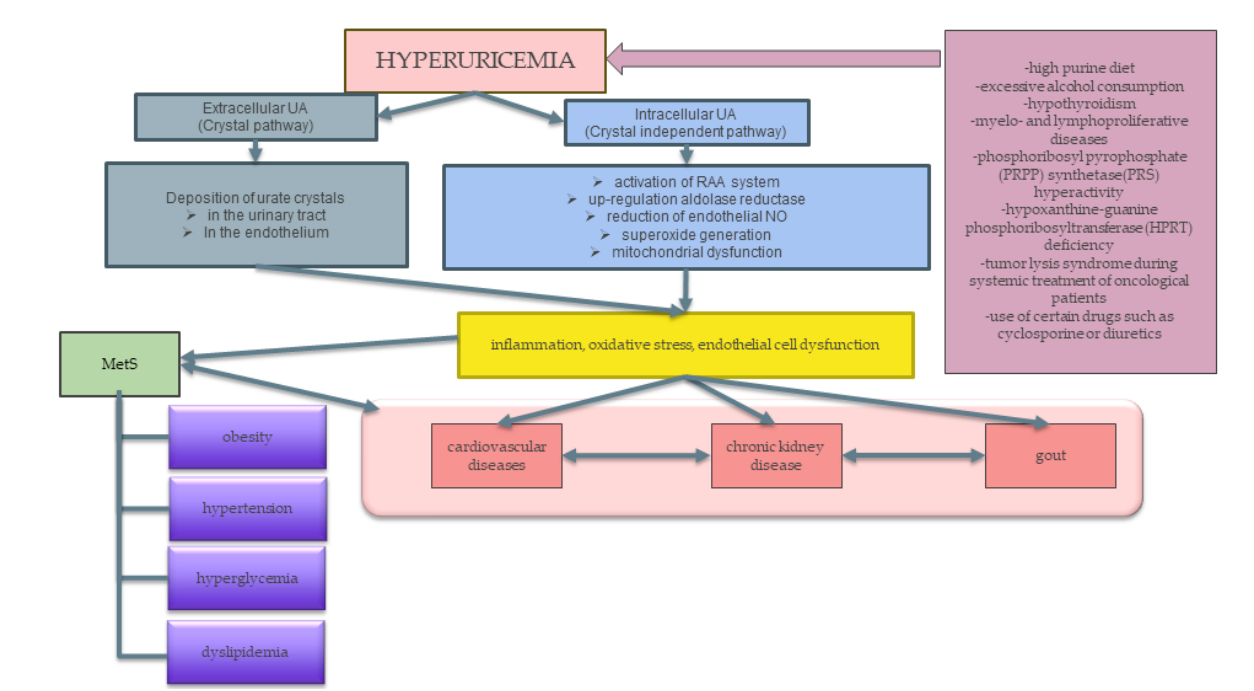
Figure 1. The relationship between hyperuricemia and MetS. Factors such as a high purine diet, high alcohol consumption, certain diseases, consumption of certain drugs, or metabolic disorders lead to an increase in the level of uric acid in the blood, which then causes an increase in inflammation, oxidative stress, and epithelial cell dysfunction. This leads to the development of MetS-related illnesses and diseases, gout, cardiovascular disease, and chronic nephritis. Abbreviations: MetS—metabolic syndrome; RAA—renin–angiotensin–aldosterone; NO—nitric